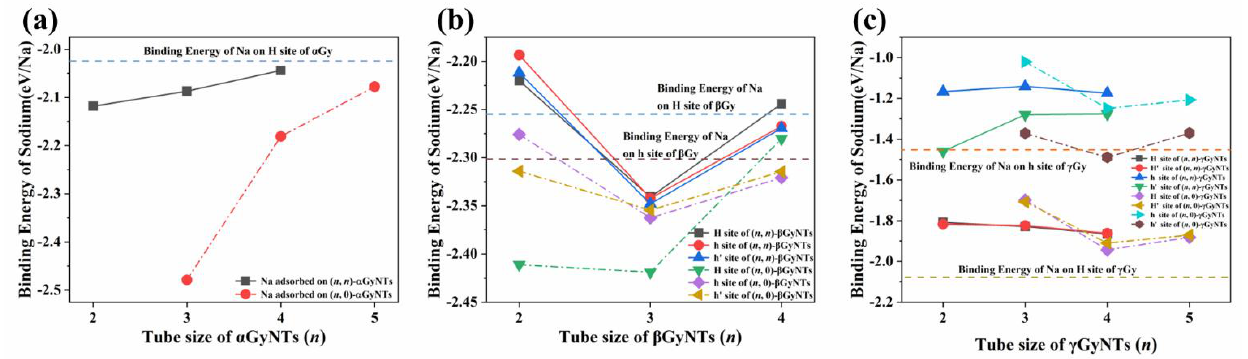
Figure 3. The change of E b of single Na as a function of tube size for ( a ) α GyNTs, ( b ) β GyNTs, and ( c ) γ GyNTs.